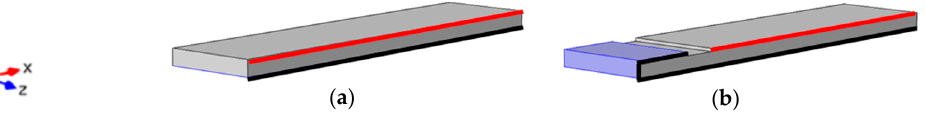
Figure 1. Gallium phosphate piezoelectric wafer active sensors with: ( a ) Parallel electrode; ( b ) Wrap-around electrode configuration. The input terminal and ground electrodes are highlighted in red and black